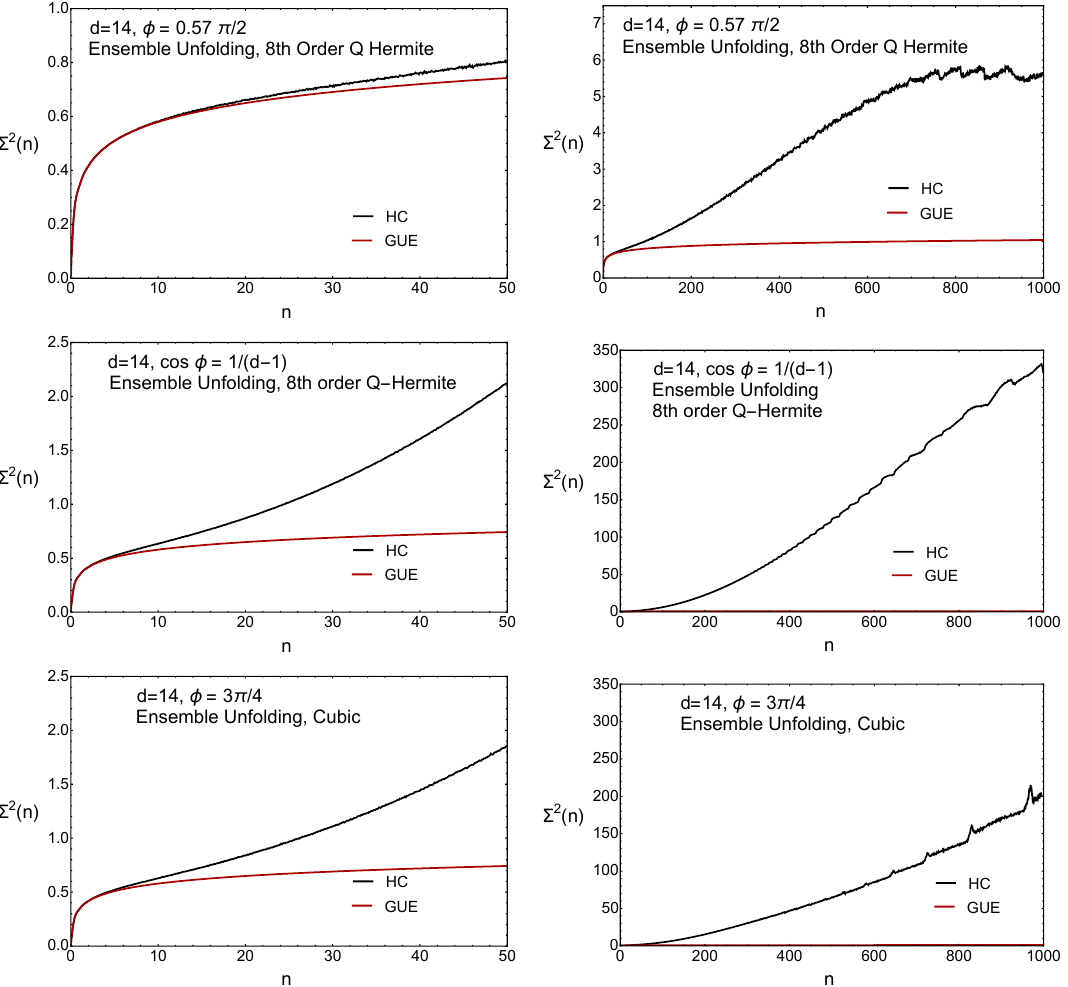
Figure 5 . The number variance Σ 2 ( n ) versus n for φ = 0 . 57 π/ 2 , φ = 0 . 95 π/ 2 and φ = 3 spectra have been unfolded using the ensemble average of the spectral density. The right figures show the number variance for larger values of n